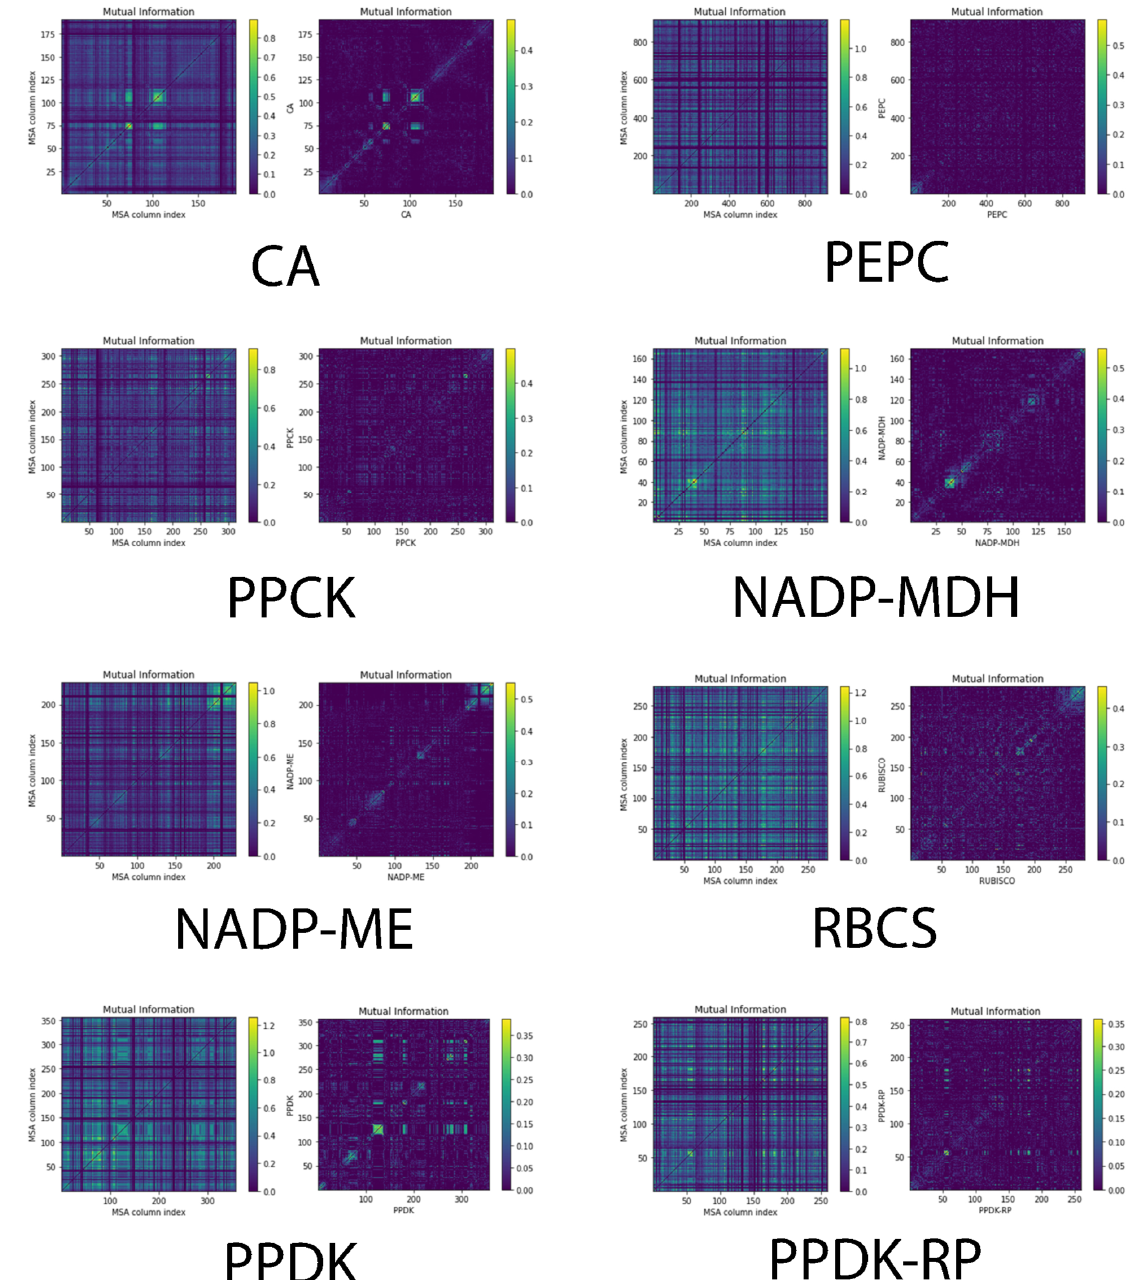
Figure 3. Identification of N-terminus co-varying sites in diverse C4 NADP-ME photosynthetic enzymes for carbon delivery. The sites were calculated based on mutual information theory. The left panels are the correlation of sites in the MSA format for each protein. The right panels are the heatmap diagram of these co-varying